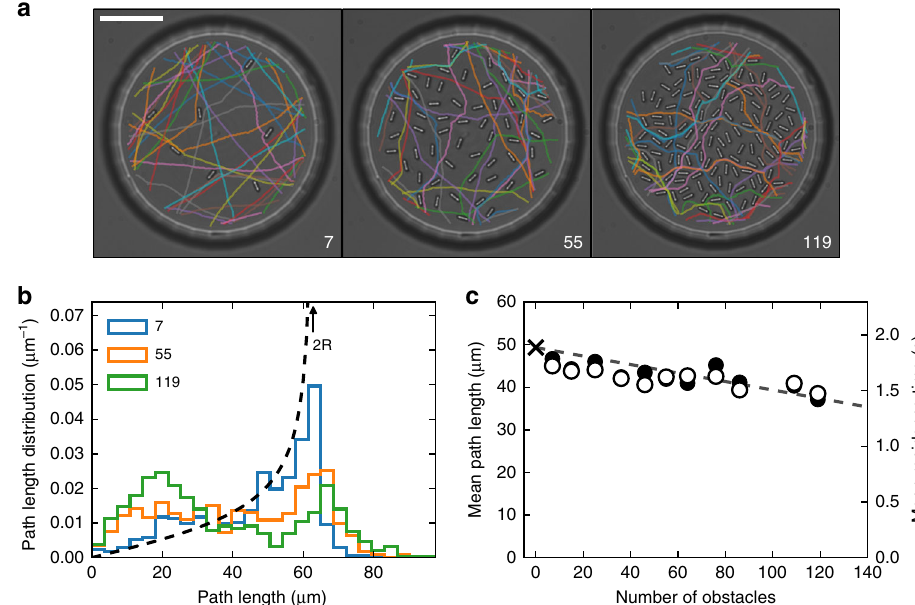
Fig. 1 Invariance in structures with varying obstacle density. a Optical microscopy images of three sample microstructures with number of obstacles 7, 55, and 119. The scalebar is 20 μ m. The colored lines are sample trajectories of swimming bacteria inside the micro-structures. As the number of obstacles increases, trajectories become more irregular due to scattering by obstacles. b Path length distributions (colored bar plot) for the structures displayed in a . The dashed line is the theoretical prediction in the absence of obstacles. c Full symbols (left y -axis) and open symbols (right y -axis) represent respectively the mean path length and the mean residence time as a function of the number of obstacles. The cross is the prediction of the invariance theorem in the absence of obstacles. The dashed line is a linear fi t with the modi fi ed formula that accounts for the excluded surface due to obstacles (Eq.